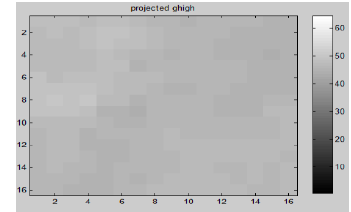
Figure 5b. Projected 16 × 16 pixels for green channel